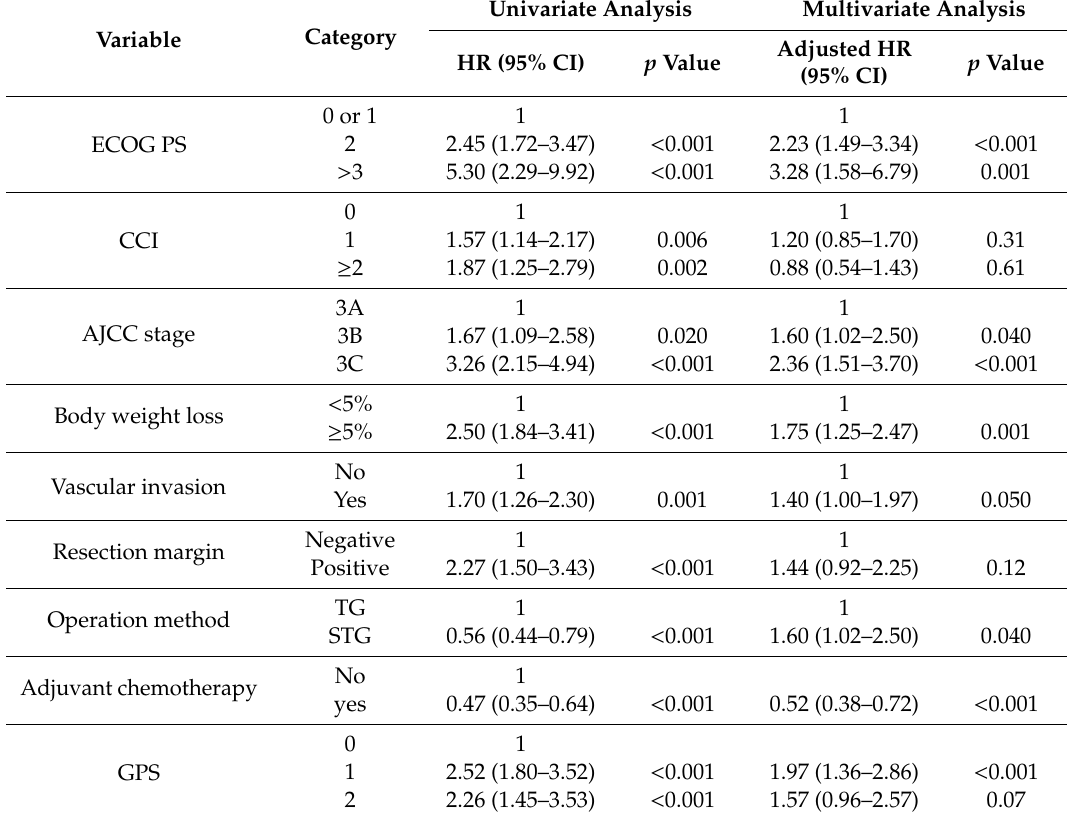
Table 2. Univariate and multivariate Cox regression analysis for overall